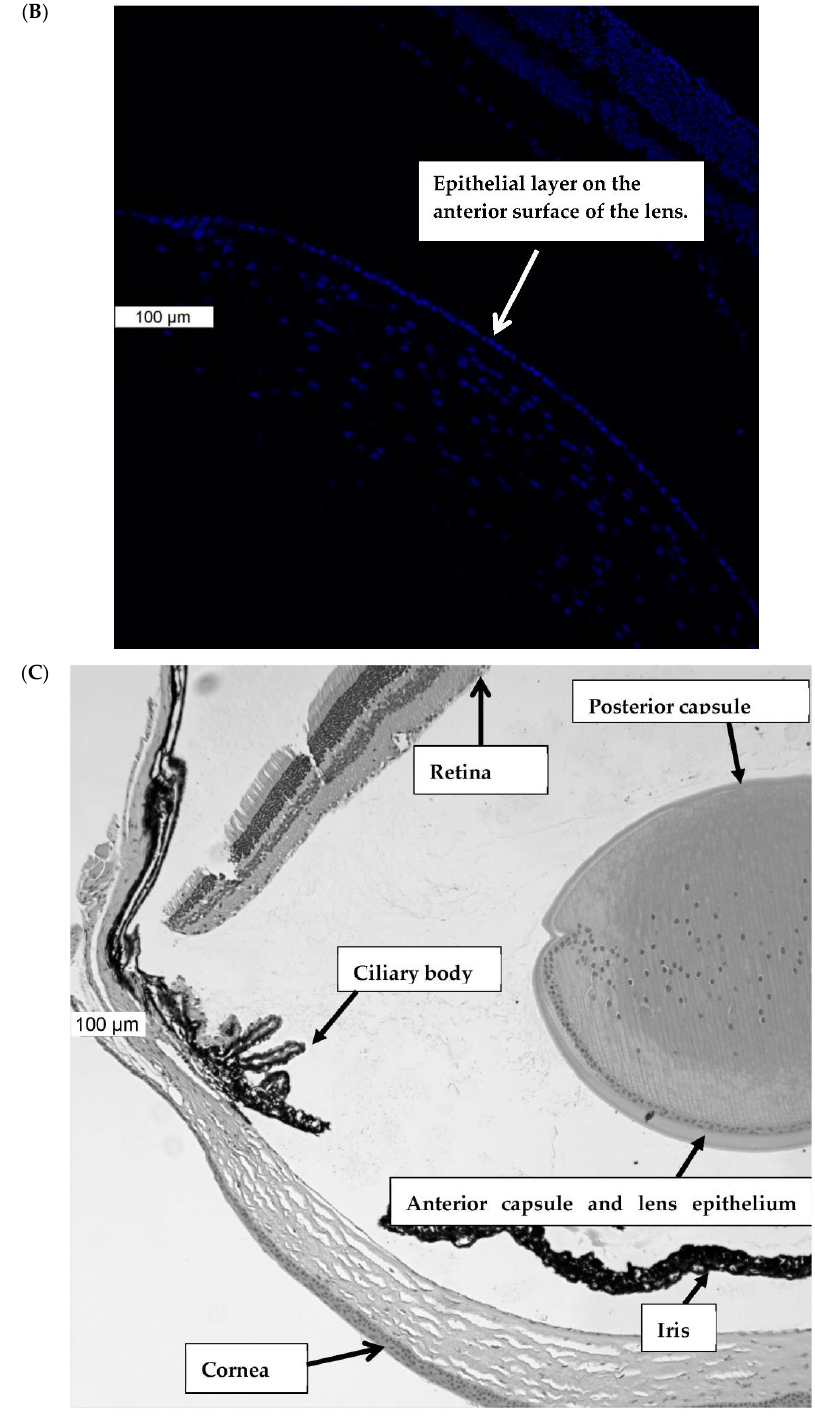
Figure 1. Immunolocalization of piezo1 in mouse lens. ( Panel A ) shows piezo1 (green) and nuclei (blue) in the epithelial cell monolayer, which covers the anterior surface of the lens. The image shows the equatorial region of the lens, where nuclei are evident in the differentiating fiber cells of the outer lens cortex. ( Panel B ) shows the negative control, in which no primary antibody was used. ( Panel C ) shows a section of the eye, stained with Hematoxylin and Eosin, that shows the lens with respect to the iris, ciliary body, retina, and cornea. The epithelial cell layer, which plays a critical role in ion transport, is positioned at the anterior lens surface, but not at the posterior